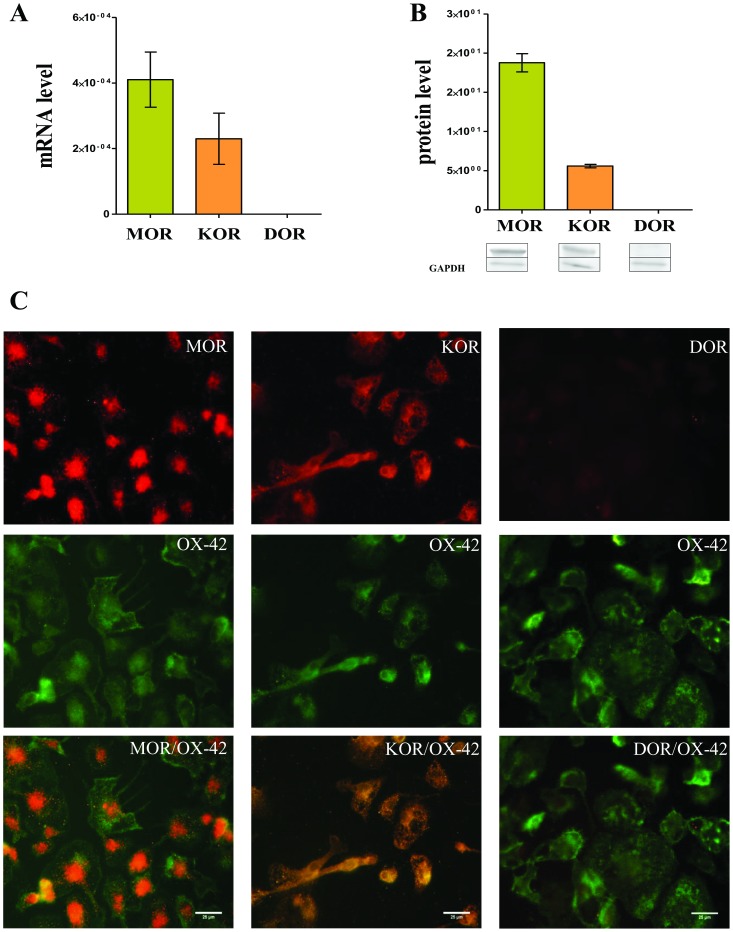
The presence of opioid receptors on microglia cells - in vitro studies.We analysed the presence of opioid receptors in primary microglial cell cultures. Using reverse transcriptase-polymerase chain reaction, we found that mRNA for MOR and KOR, but not DOR, is expressed in rat primary microglial cells cultures (A). Western blot analysis (B) detected proteins for MOR and KOR, but not DOR, in microglia. The presence of MOR and KOR, but not DOR, were confirmed by immunocytochemistry (C), and we show the colocalisation of MOR (left panel) and KOR (middle panel) antibodies (red) with OX/42 antibodies (green). The scale bar for all microphotographs is 25 µm. The data from 3–10 cell cultures are presented.